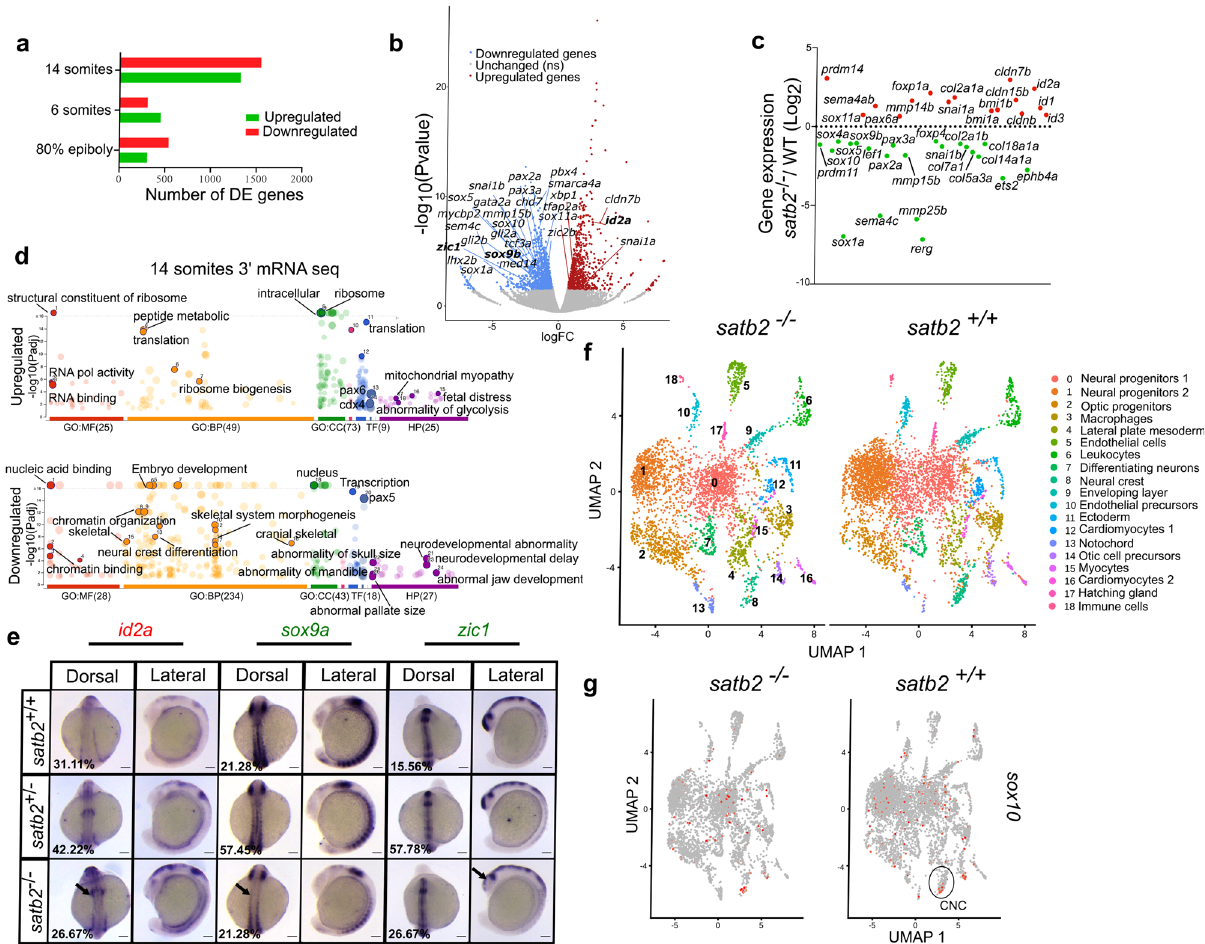
Fig. 2 Deregulation of gene expression in satb2 mutants at the onset of organogenesis leads to defective neurogenesis and craniofacial patterning. a Bar plot for the number of upregulated (red) and downregulated (green) genes from 3 ′ mRNA-seq datasets at the respective stages. b Volcano plot of differentially expressed genes at 14 ss embryonic stage. DE genes with FDR < 0.1 and log2 fold change > ±0.58 are colored as red for signi fi cantly upregulated, blue for signi fi cantly downregulated, and gray for unchanged or non-signi fi cant genes. Few signi fi cantly differentially expressed genes representing GO categories neural crest differentiation, neurogenesis, and cranial skeletal system development are highlighted. c Scatter plot for log2 fold change in gene expression of various gene families belonging to the above-mentioned GO categories. d GO analysis of dysregulated genes at 14 ss highlighting signi fi cant classes under molecular function (MF), biological processes (BP), cellular components (CC), transcription factors (TF) and human pathology (HP) categories. e Dorsal and lateral view of WISH for id2a (upregulated) n = 48, N = 3; sox9a , n = 47, N = 3 and zic1 , n = 45, N = 3 (downregulated). Arrows in the respective images mark the region of maximum differences in the expression pattern. Scale bar = 100 µ m. f UMAP clusters illustrate 19 distinct cell types through integrated scRNAseq analysis on satb2 − / − and satb2 + / + embryos at 14 ss. g UMAP highlighting (circled) cranial neural crest cells cluster expressing sox10